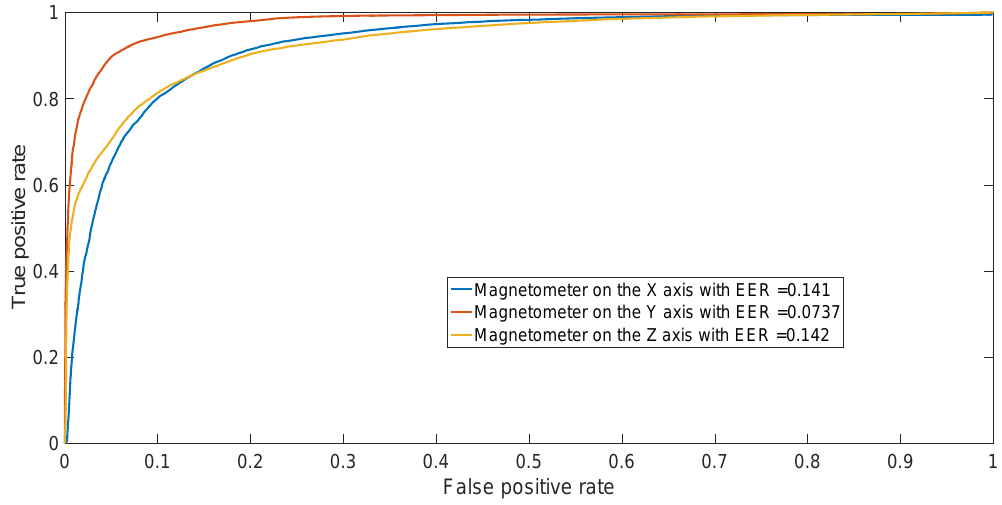
Magnetometer on the X axis with EER =0.141 Magnetometer on the Y axis with EER =0.0737 Magnetometer on the Z axis with EER =0.142